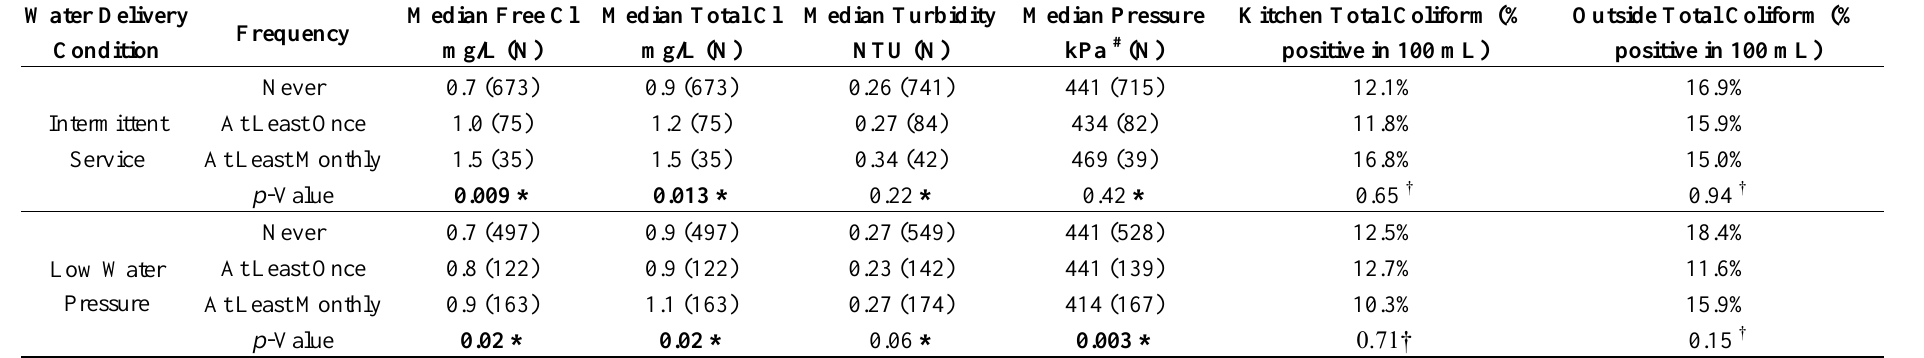
Table 3. Association between reported intermittent service and low water pressure and measured water quality in a sample of households of three rural counties in Alabama 2012.